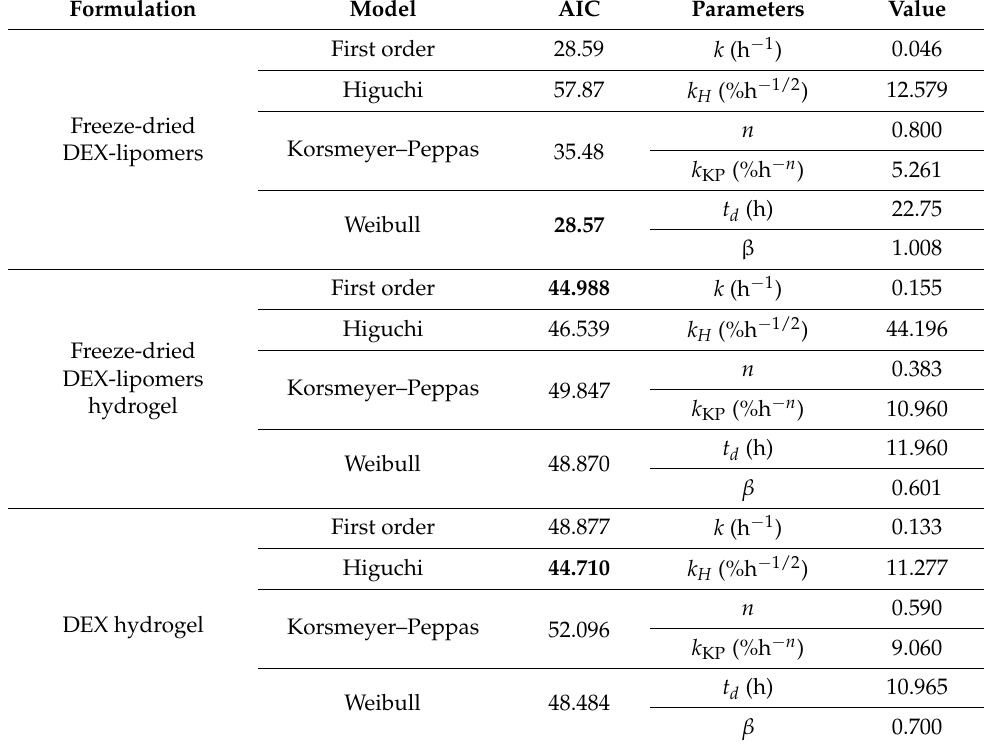
Table 8. Results of model fitting of DEX drug release for the prepared formulations. AIC in bold corresponds to the model that best fit the experimental data. “ n ” corresponds to the release exponent of Korsmeyer–Peppas (KP)